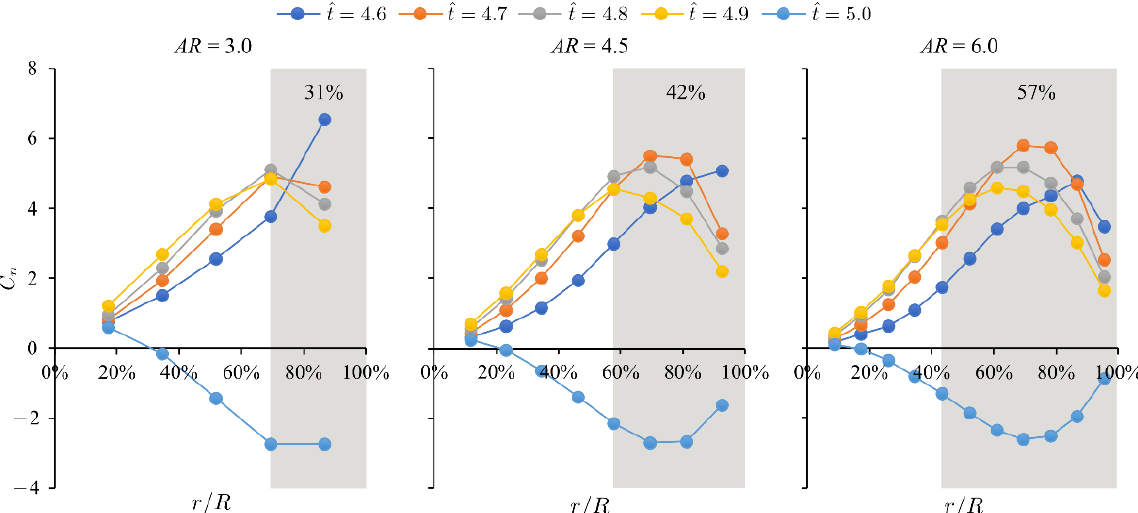
Figure 4. Normal force coefficient distribution along the wingspan for wings with different aspect ratios. Grey areas represent regions where the normal force coefficient at 𝑡̂ = 4.9 becomes lower than that at 𝑡̂ = 4.8. Stroke amplitude is fixed to 160° and the dimensionless radial centroid location is fixed to 0.5.